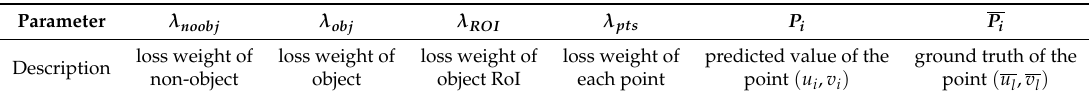
Table 3. The meaning of the parameters of Loss